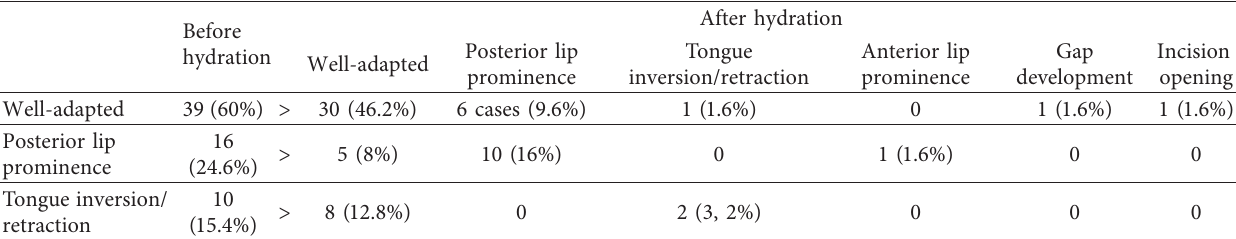
Figure 4: Worsening of corneal incision morphology after its hydration. Well-adapted corneal incision before hydration (a), anterior lip prominence centrally from the inner orifice developed after lateral stromal hydration (b). Tongue inversion into the incision before (c) and after (d) lateral stromal hydration. Table 2: Condition of corneal incision before and after